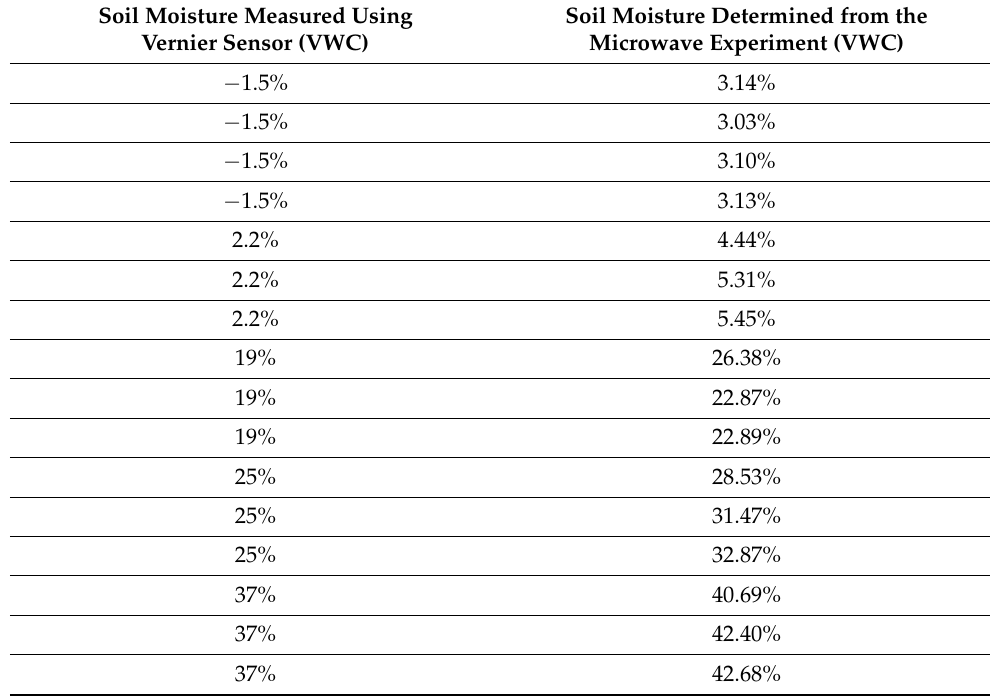
Table 1. Comparison of soil moisture values.